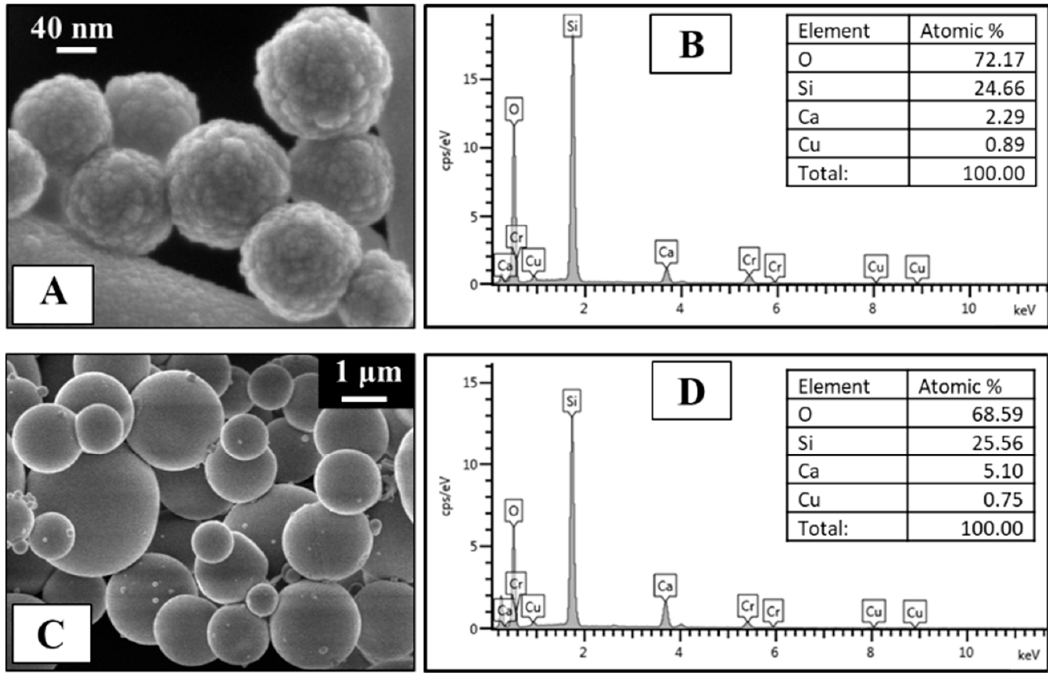
Figure 1. Field-emission scanning electron microscopy (FE-SEM) image of MBG_Cu2%_SG_Ibu ( A ) and MBG_Cu2%_SD_Ibu ( C ). Energy dispersive spectroscopy (EDS) spectrum of MBG_Cu2%_SG_Ibu ( B ) and MBG_Cu2%_SD_Ibu ( D ).